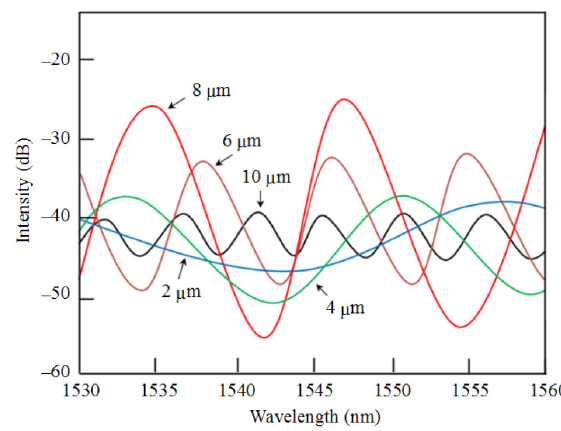
Fig. 3 Spectra of the dislocation fiber MZI-based sensor with SMF2 length of 2 mm, 4 mm, 6 mm, 8 mm, 10 mm, and offsets of 6 μm .